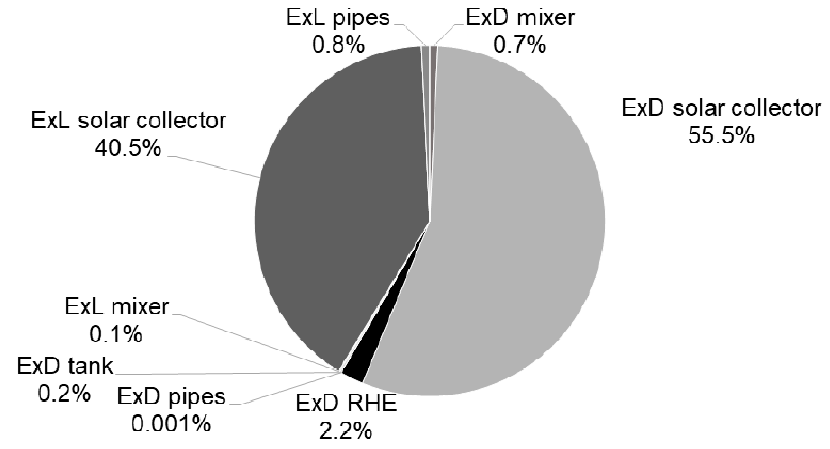
Figure 6. Relative exergy losses and destructions during the daily operation of the system in Manila, May.